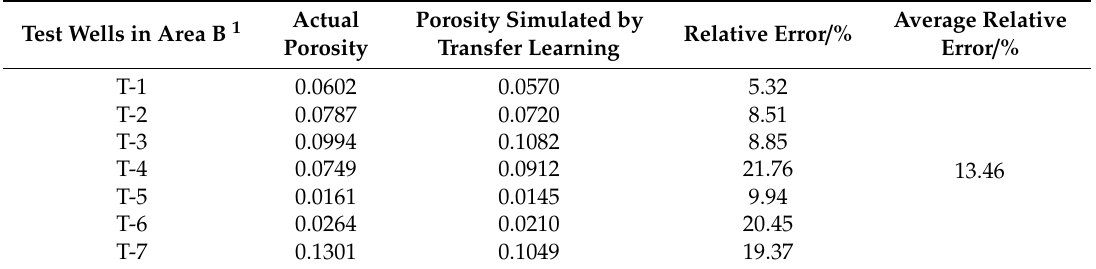
Table 5. Test well experiment for porosity modeling based on transfer